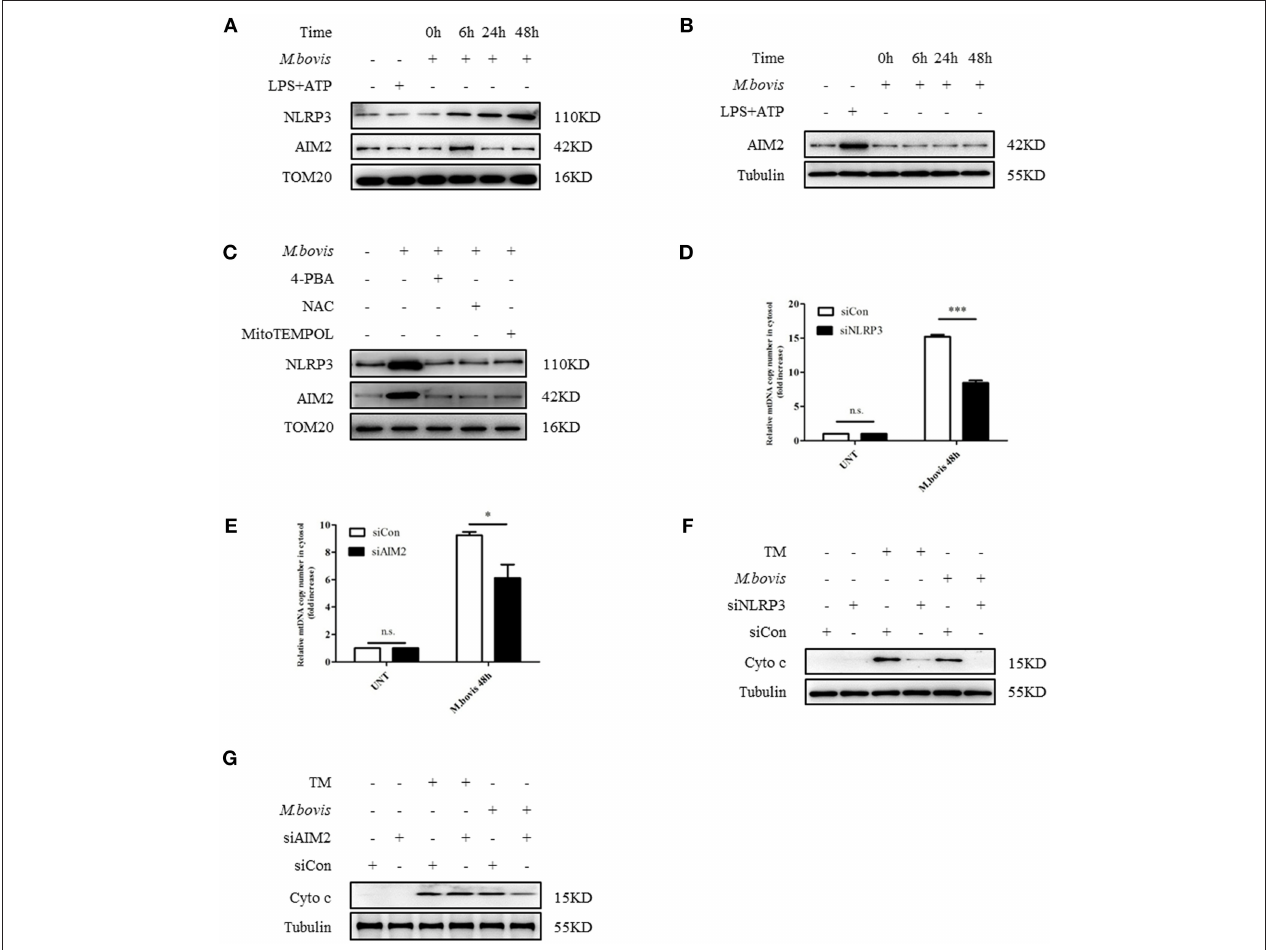
FIGURE 3 | NLRP3 and AIM2 mediate ERS-induced mitochondrial damage. (A) Immunoblot analysis at different time points of NLRP3 and AIM2 at the mitochondrial fraction of BMDMs infected with M. bovis (MOI 10). (B) Immunoblot analysis at different time points of AIM2 in lysates of BMDMs infected with M. bovis (MOI 10). The control image is the same to Figure 2A . (C) Immunoblot analysis of NLRP3 and AIM2 at the mitochondrial fraction of BMDMs infected for 6h with M. bovis (MOI 10) in the presence or absence of 4-PBA, NAC and Mito TEMPOL. (D) qPCR analysis of mtDNA release into the cytosol in M. bovis -infected BMDMs transfected with control non-targeting siRNA (siCon) or NLRP3-targeting siRNA (siNLRP3) and then infected for 48h with M. bovis (MOI 10). (E) qPCR analysis of mtDNA release into the cytosol in M. bovis -infected BMDMs transfected with control non-targeting siRNA (siCon) or AIM2-targeting siRNA (siAIM2) and then infected for 48h with M. bovis (MOI 10). (F) Immunoblot analysis of cytochrome c in cytosolic extracts from BMDMs transfected with control non-targeting siRNA or NLRP3 targeting siRNA and then infected for 48h with M. bovis (MOI 10). (G) Immunoblot analysis of cytochrome c in cytosolic extracts from BMDMs transfected with